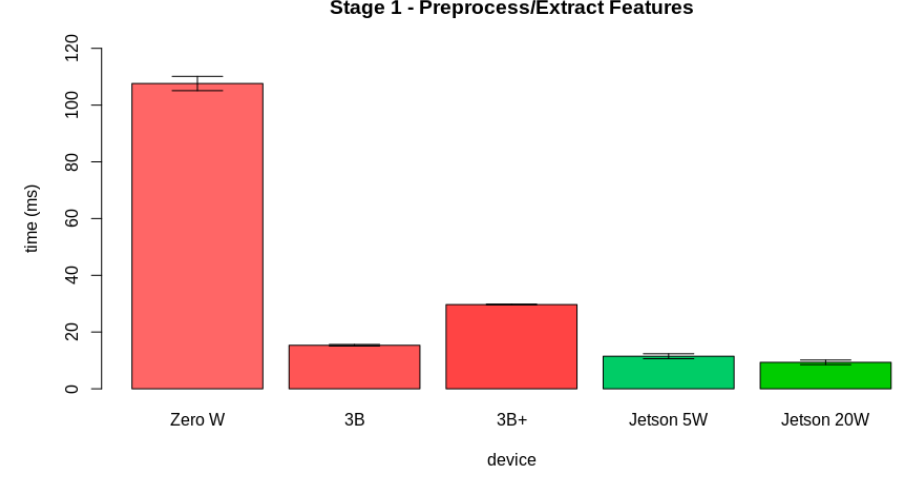
Figure 18. Latency results for the first stage.